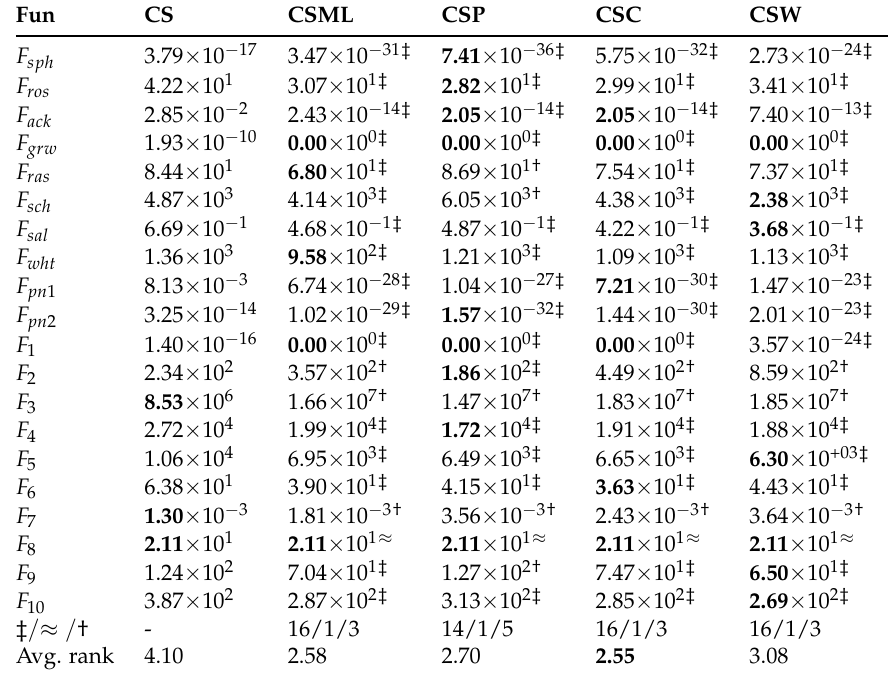
“‡”, “†” and “ ≈ ” respectively denote the performance of CS is worse than, better than, and similar to those of the proposed algorithms according to the Wilcoxon’s rank test at a 0.05 significance level. Table 4. Comparison results between CS and four randomness-enhanced CS algorithms at D = 50.